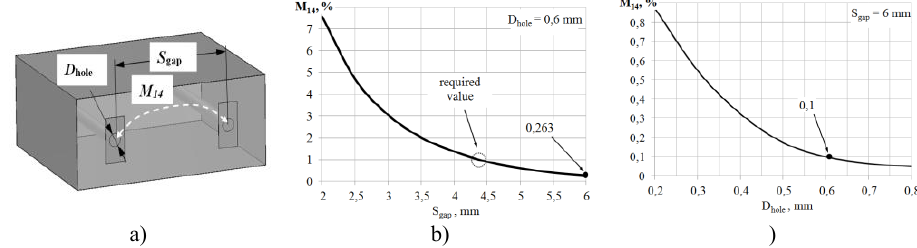
Fig. 5. Electromagnetic model of external resonators in HFSS (a), the cross coupling coefficient vs distance between the resonators (b) and diameters of the holes (c).